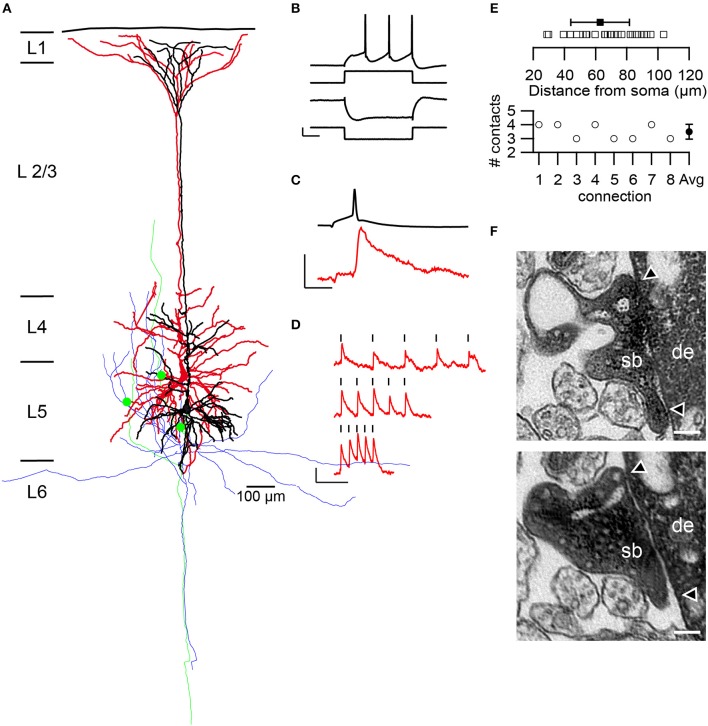
Structural and functional characteristics of L5B thick-tufted pyramidal neurons and synapses. (A) Neurolucida reconstruction of a synaptically coupled pair of L5B thick-tufted pyramidal neurons filled with HRP. The dendritic tree of the presynaptic neuron is given in black and that of the postsynaptic neuron in red, the axonal arborizations in green and blue, respectively. Three synaptic contacts (green dots) were established at different locations on the basal dendritic tree of the postsynaptic neuron. (B–D) Example recordings from the pair shown in (A). Pre- and postsynaptic membrane potentials are depicted in black and red, respectively. (B) L5B thick-tufted pyramidal neurons typically exhibited a sagging membrane potential in response to a hyperpolarizing, and a regular firing pattern, to a depolarizing square current pulse. Scale bars: 40 pA and 5.3 and 12 mV for the hyperpolarizing and depolarizing membrane potential, respectively, and 50 ms. (C) An averaged EPSP (red) in response to low frequency (0.125 Hz) APs in the presynaptic neuron. Scale bars: 0.2 and 76 mV for the EPSP and AP, respectively and 10 ms. (D) Temporal modulation of the EPSP amplitudes during trains of APs at increasing frequencies. APs were marked by the black strokes. Intra-train frequencies were 10, 20, and 40 Hz from top to bottom. (E) Summary of the geometric distance of synaptic contacts (open squares) and their average (solid squares) and SD (solid line). The lower panel shows the number of synaptic contacts per connection as determined from 3D Neurolucida (n = 8) reconstructions with an average of 3.5 ± 0.5 (SD) contacts. (F) Two electron microscopically identified en passant synaptic boutons (sb) established on different locations on basal dendrites (de) of the postsynaptic pyramidal cell depicted in (A). The two arrowheads indicate the synaptic apposition zones. Scale bar 0.1 μm.